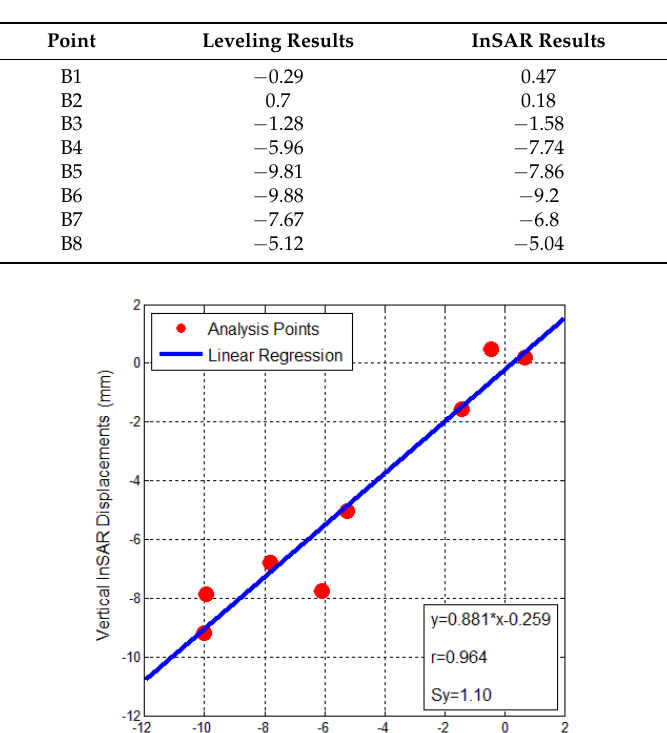
Figure 10. Ordinary Least Squares (OLS) Regression analysis in vertical displacements of the Bohai Building between extracted from InSAR and surveyed from leveling.